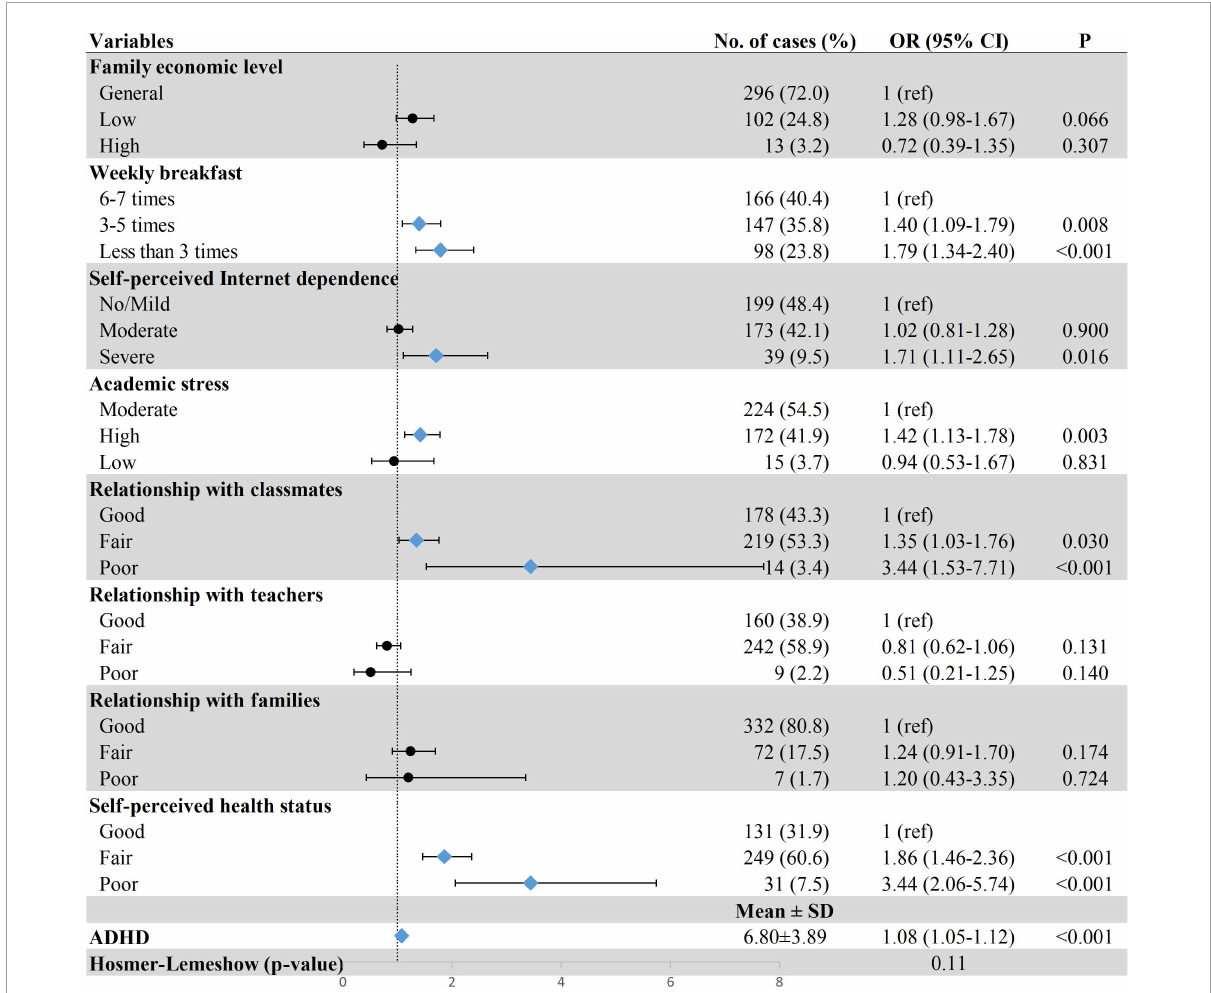
FIGURE1 Association between demographic and clinical characteristics and possible sleep disturbance. Row with blue diamond indicates statistical significance. ADHD, attention-deficit/hyperactivity disorder; OR, odds ratio; 95% CI, 95% confidence interval.